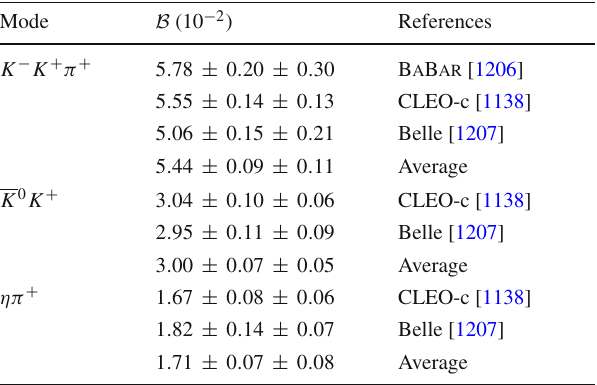
Table 285 Experimental results and world averages for branching fractions of D + s → K − K + π + , D + s → K 0 K + , and D + s → ηπ + decays. The first uncertainty is statistical and the second is experimen- tal systematic. CLEO-c reports in Ref. [1138] B ( D + s → K 0 include it in the average of B ( D + s → K 0 K + ) by using the relation